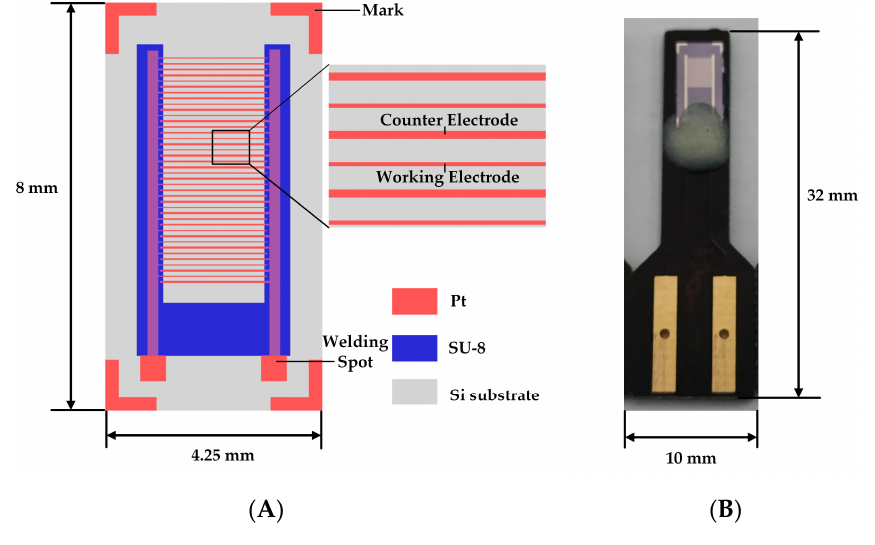
Figure 3. UIAE chip: ( A ) Structure diagram; ( B )